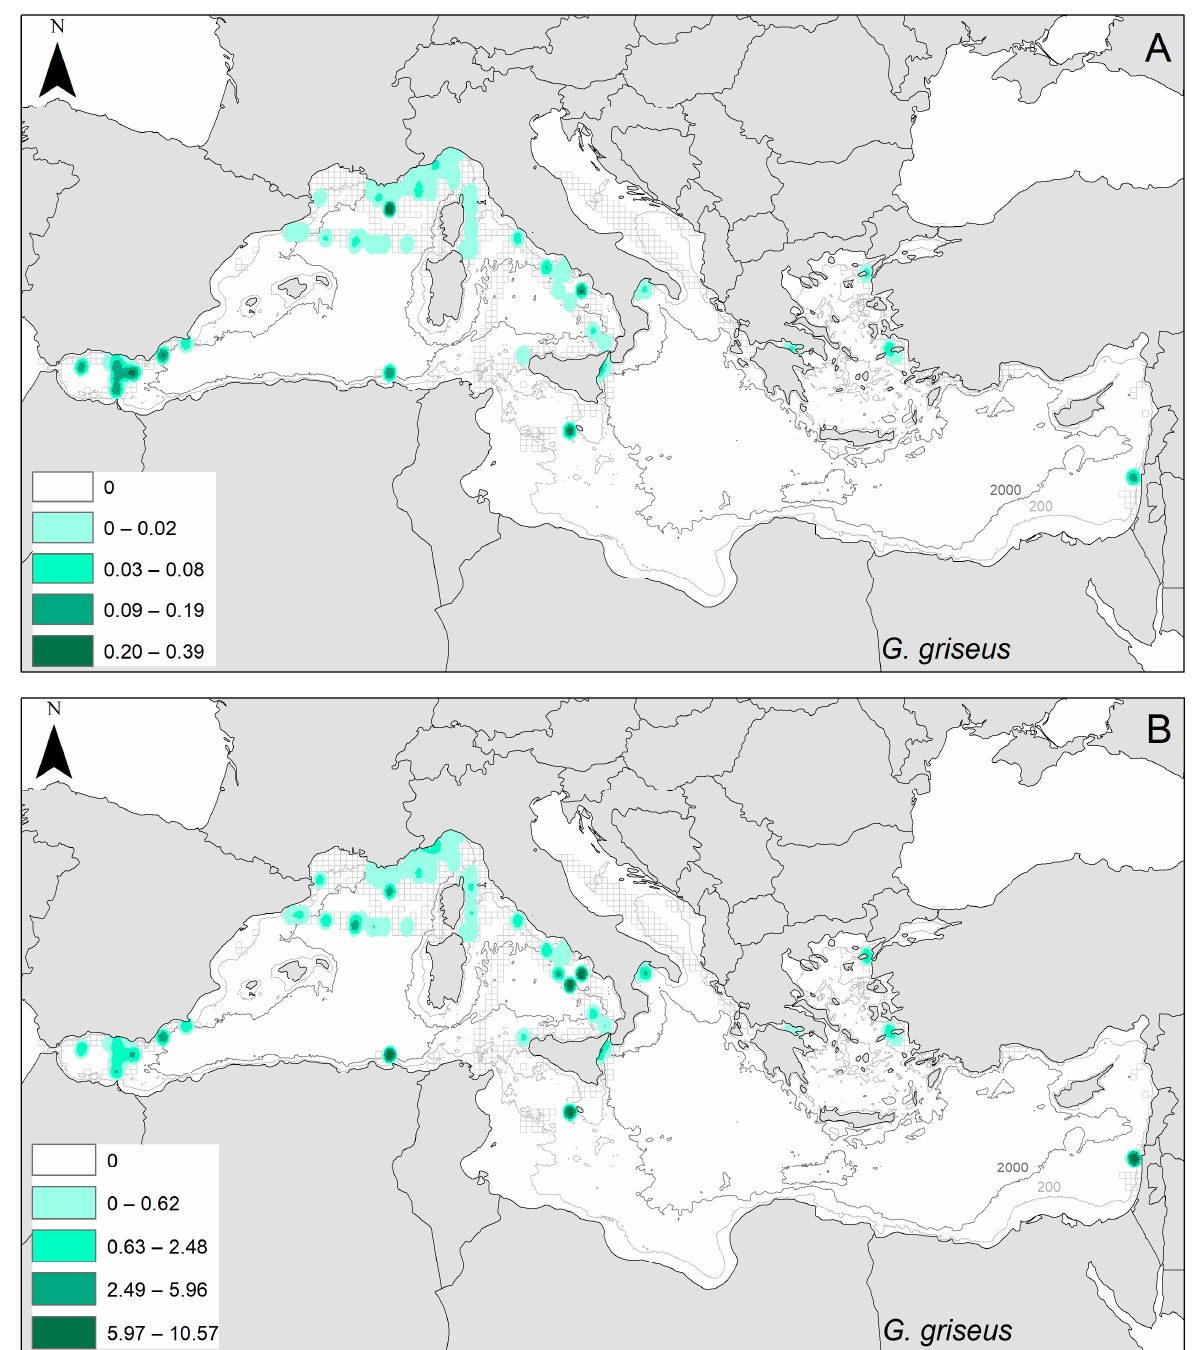
waters of the continental shelf and slope. In the Ligurian and Tyrrhenian Sea, its ER is much lower, and this species seems to prefer the open waters outside the continental shelf (>200 m). In the Ae- gean Sea, the ER increases and the common dolphin seems to find its privileged habitat at the upper edge of the continental slope, close to the platform. The prevalence map ( B ) shows an inverse pattern to that of the striped dolphin (Figure 6B), with prevalence levels increasing from north to south and from west to east (Kernel density parameters: cell size x, y = 5 × 5 km; radius ≈ 30 km; criterion for division into classes: natural breaks).